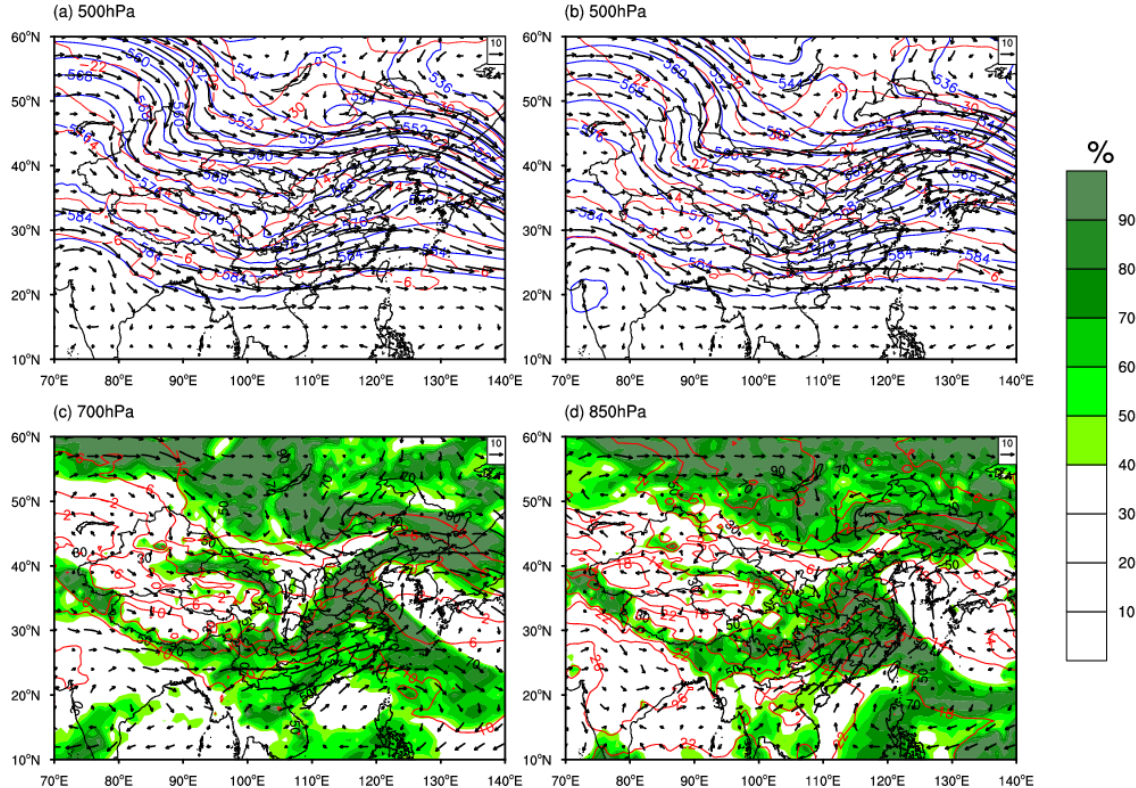
Figure 2. 500 hPa geopotential height (blue solid lines, units: dagpm) and wind field (vectors, units: m·s −1 ) and temperature (red solid lines, units: °C) at 1200 UTC ( a ) and at 1800 UTC, ( b ) and wind field (vectors, units: m·s −1 ), temperature (red solid lines, units: °C) and relative humidity (shaded, units: %) at 700 hPa ( c ) and 850 hPa ( d ) at 1800 UTC on 15 April 2016.